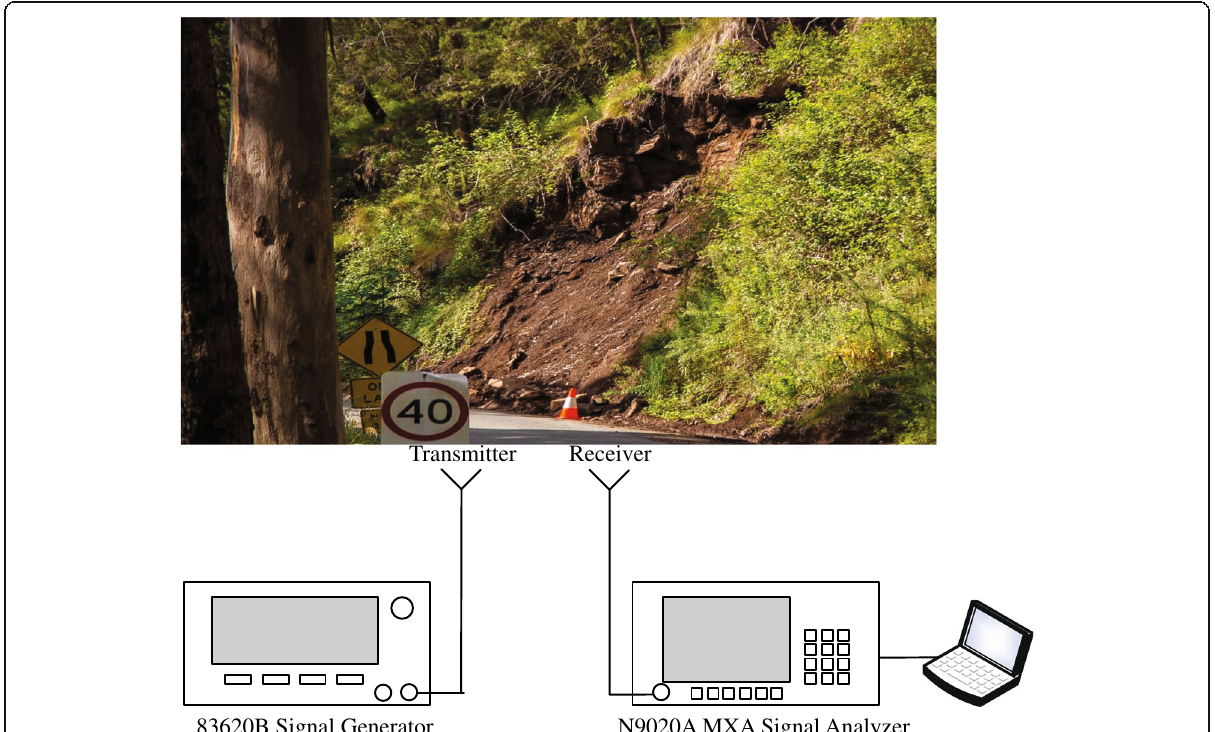
Fig. 1 Basic block diagram of the measurement